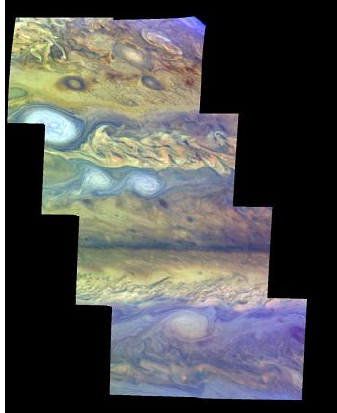
Figure 4: Turbulence in the atmosphere of Jupiter as observed by Voyager.